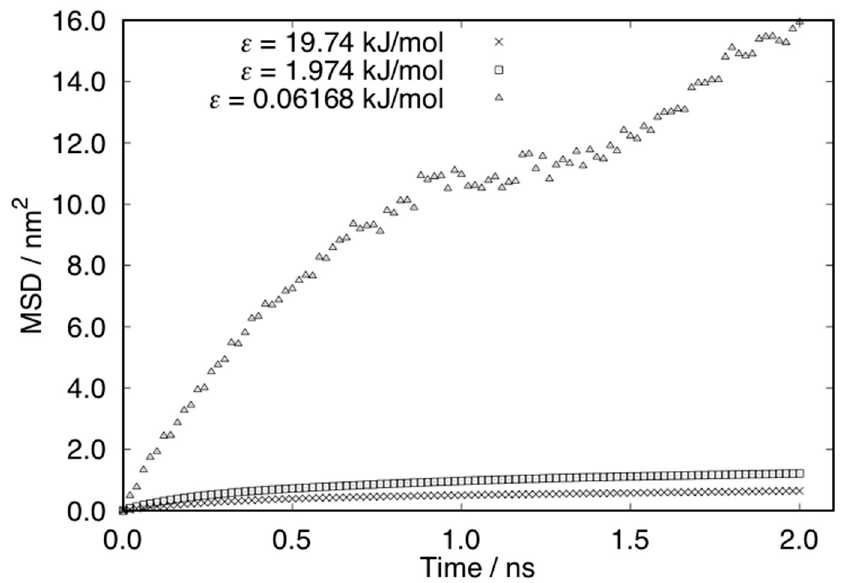
Figure 15. Mean square displacement (MSD) of water molecules in the nanostructure on surfaces.